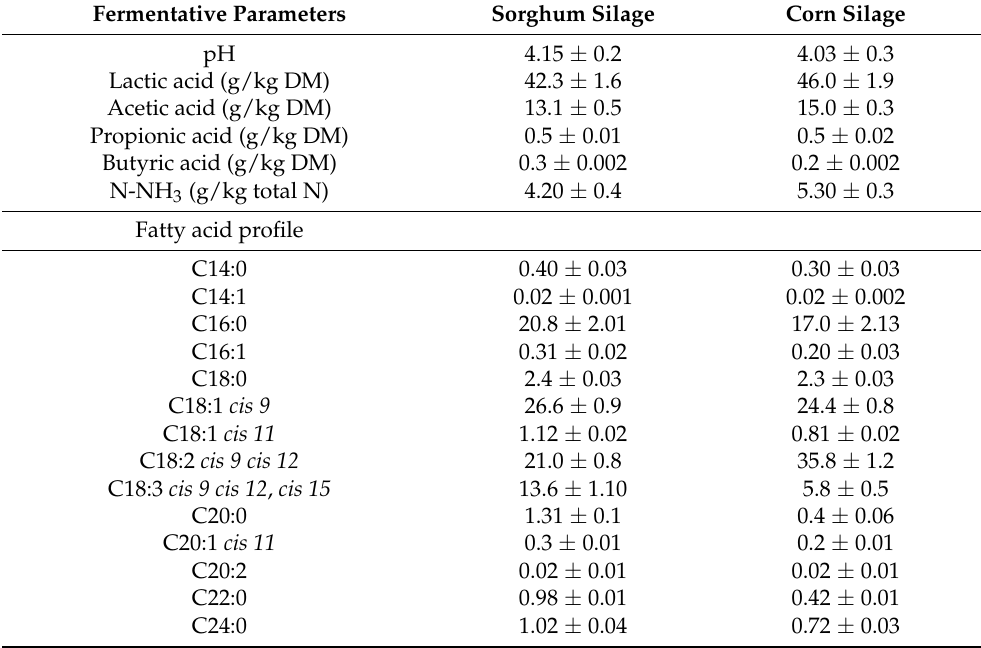
Table 3. Silages fermentative parameters and fatty acids profile (% total